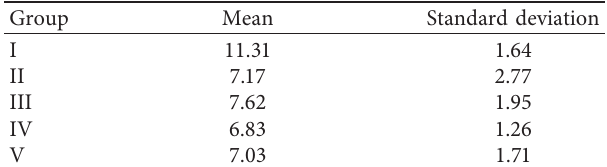
Table 6: Mean and standard deviation of the number of switches in each group of